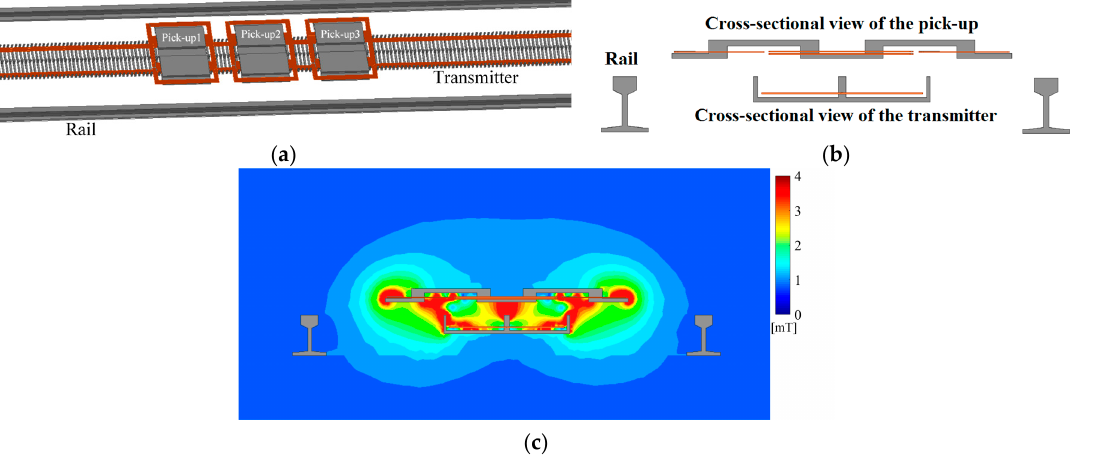
Figure 7. Finite element analysis (FEA) model and simulated magnetic flux density distribution at its rated operation: ( a ) a top view of the designed WPT system; ( b ) a cross-sectional view; and ( c ) magnetic flux density distribution at 180 kW transfer.